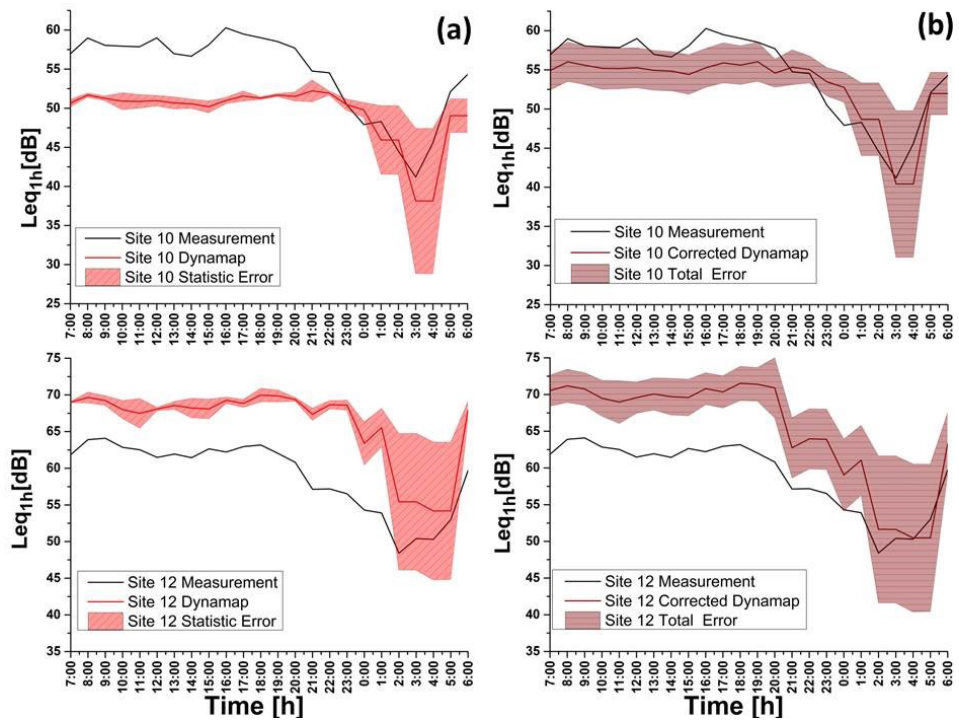
( 1 h ) ( t , s ) vs hour t of the day for: ( a ) Traffic noise Figure 9. Comparison of equivalent noise levels L eq measurements and ‘non-corrected’ Dynamap predictions for Site 10 (upper panel), and Site 12 (lower panel). The bands correspond to the statistical errors. ( b ) Traffic noise measurements and ‘corrected’ Dynamap predictions for the same sites. The bands correspond to the total errors [86]. (With permission from